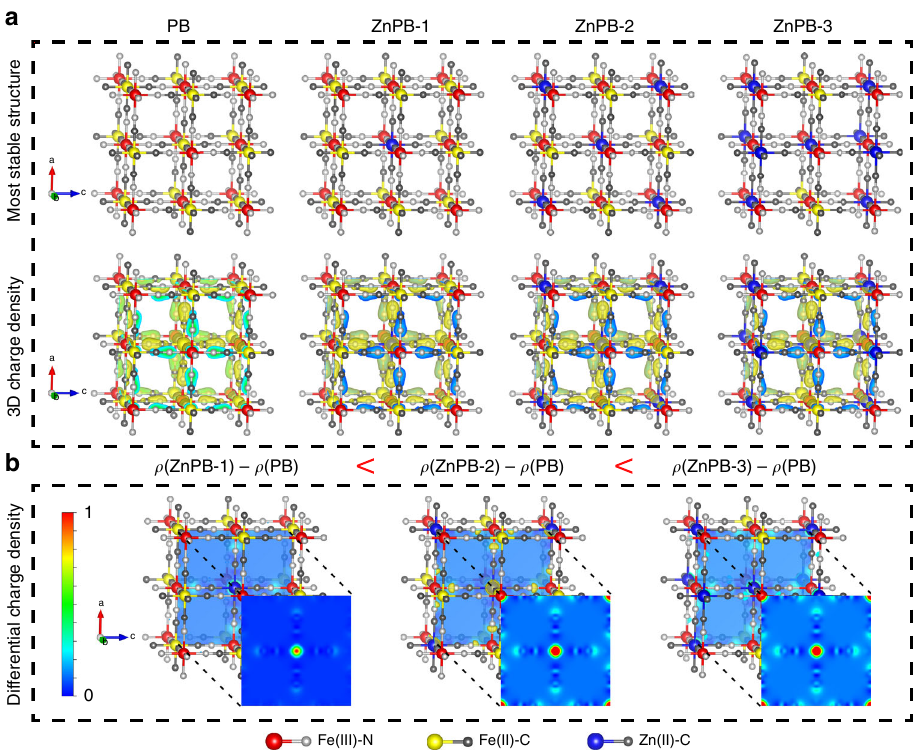
Fig. 1 Theoretical calculations. a Optimized geometrical structure of PB and ZnPB with various doping levels (colour coding: Fe(III)-red, Fe(II)-yellow, Zn- blue, N-grayish and C-dark grey); 3D charge density difference plot of the optimization of PB and ZnPB . b 2D heatmap of differential charge density of PB and ZnPB in the midpoint of each unit